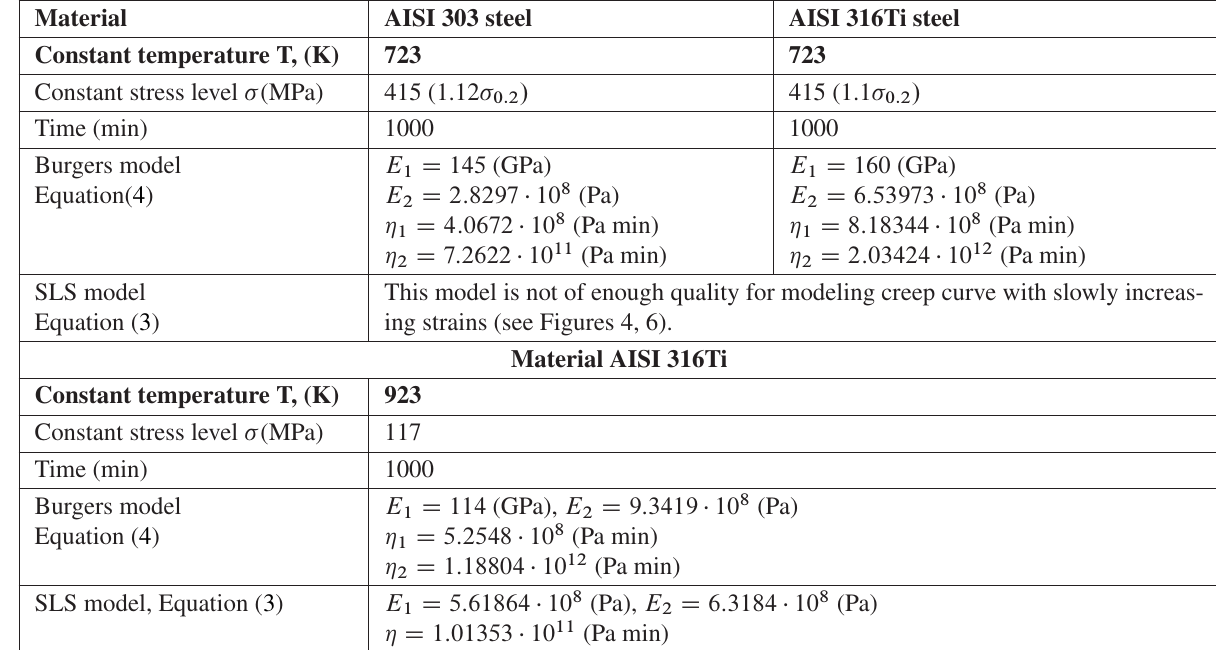
Table 3. Creep modeling